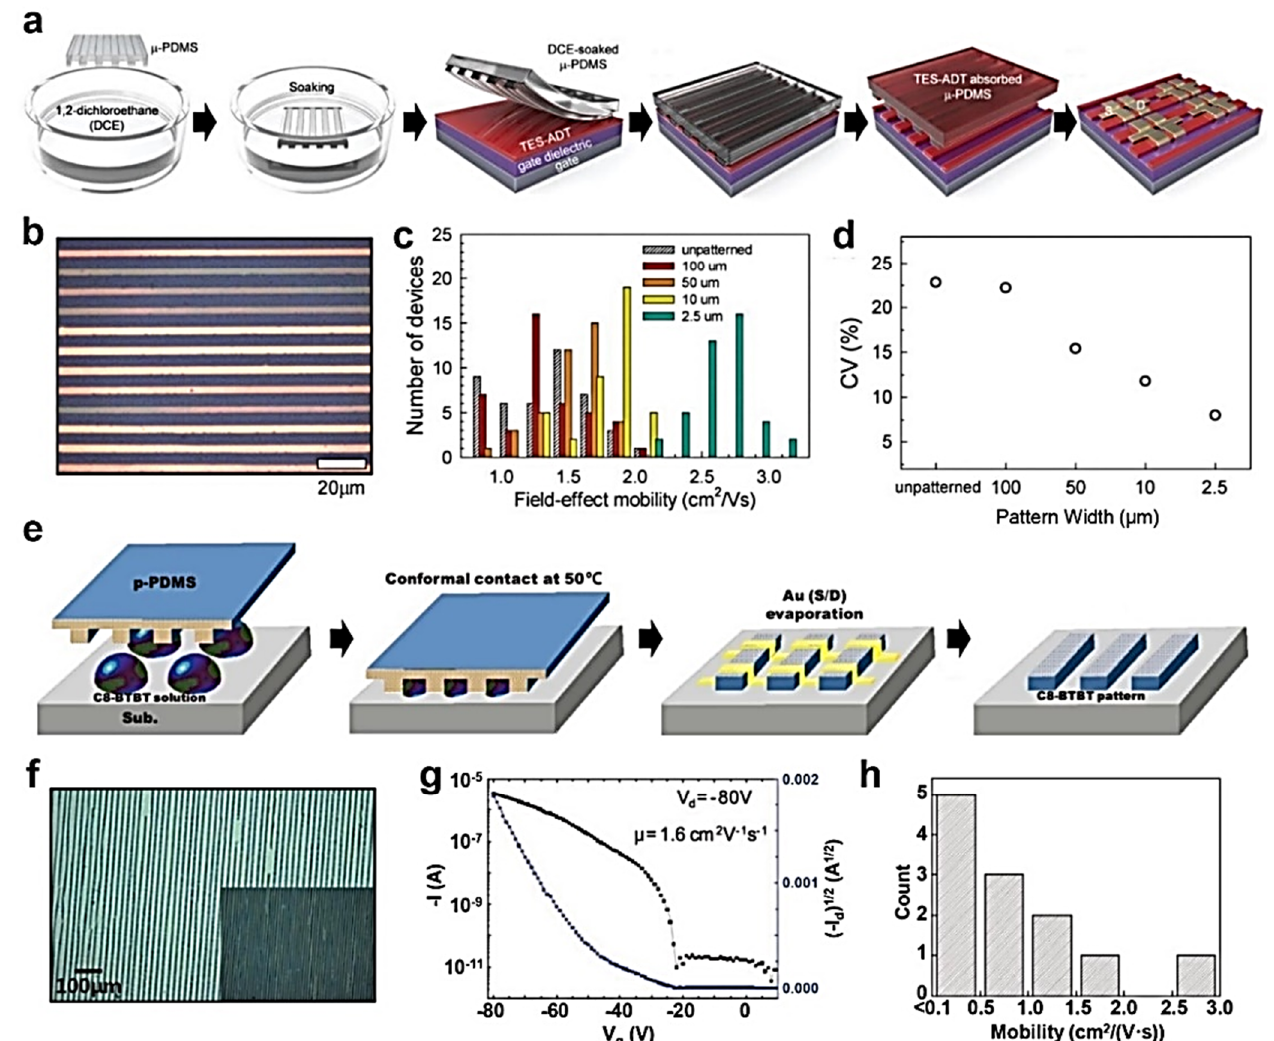
Figure 5. ( a ) Schematic illustration of the patterning process using PDMS stamp with 1,2-dichloroethane solvent. ( b ) An optical microscope image of the patterned TES-ADT semiconductor. ( c ) Distribution of µ FET s of TES-ADT-based OFETs and ( d ) the corresponding coefficient of variation (CV) values. ( e ) Schematic illustration of the patterning process using solvent-assisted capillary lithography with a PDMS stamp. ( f ) Optical microscope images of the patterned C 8 -BTBT semiconductor. ( g ) Transfer characteristic of the OFETs with C 8 -BTBT patterns. ( h ) Distribution of µ FET s of C 8 -BTBT-based OFETs. Reprinted from [51], Copyright 2016 with permission from Royal Society of